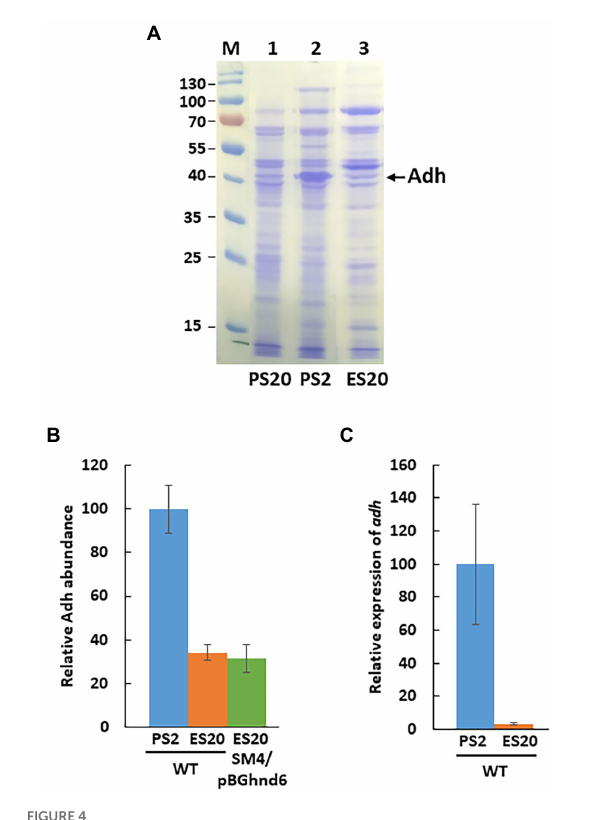
bars correspond to standard deviations.